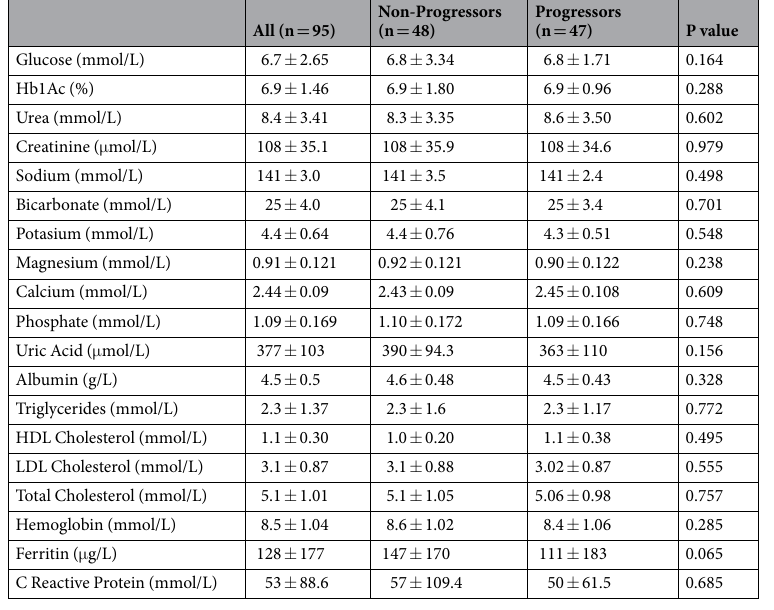
Table 2. Serum biochemical values.